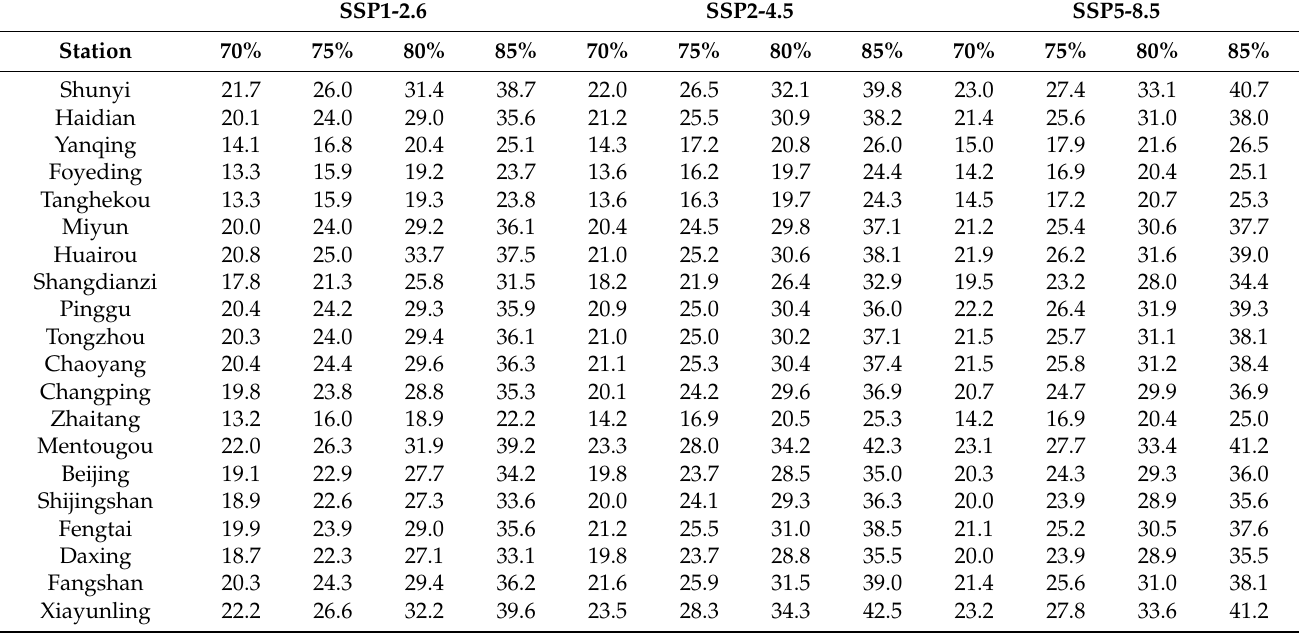
Table 4. The projected average design rainfall corresponding to the VCRs (70–85%) under different scenarios in the three models of each station in Beijing. SSP1-2.6 SSP2-4.5